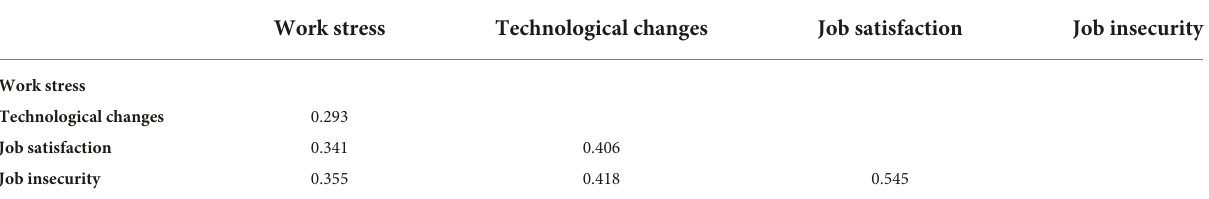
TABLE 5 Discriminant validity (HTMT